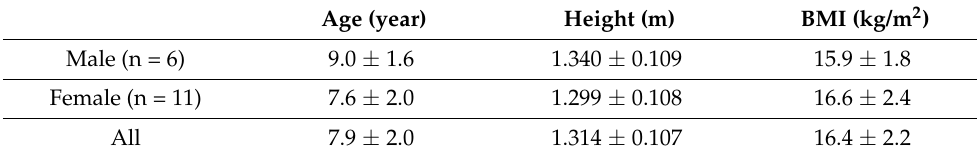
Table 1. Demographic and descriptive data of the participants (n = 17).